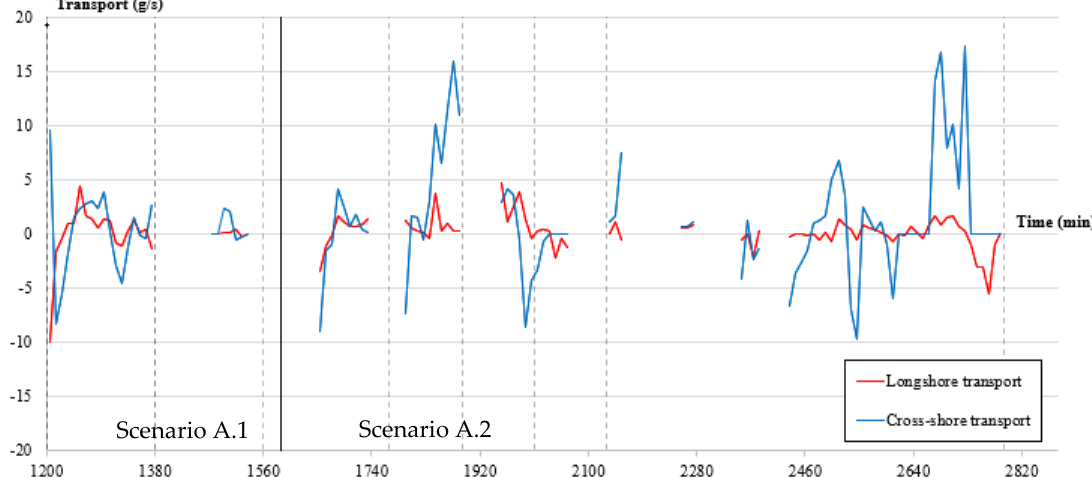
Figure 6. Timeline for the estimated suspended longshore and cross-shore sediment transport. The vertical black line represents the transition between scenarios A.1 and A.2. The vertical black dashed lines represent the instants when the equipment was stopped.